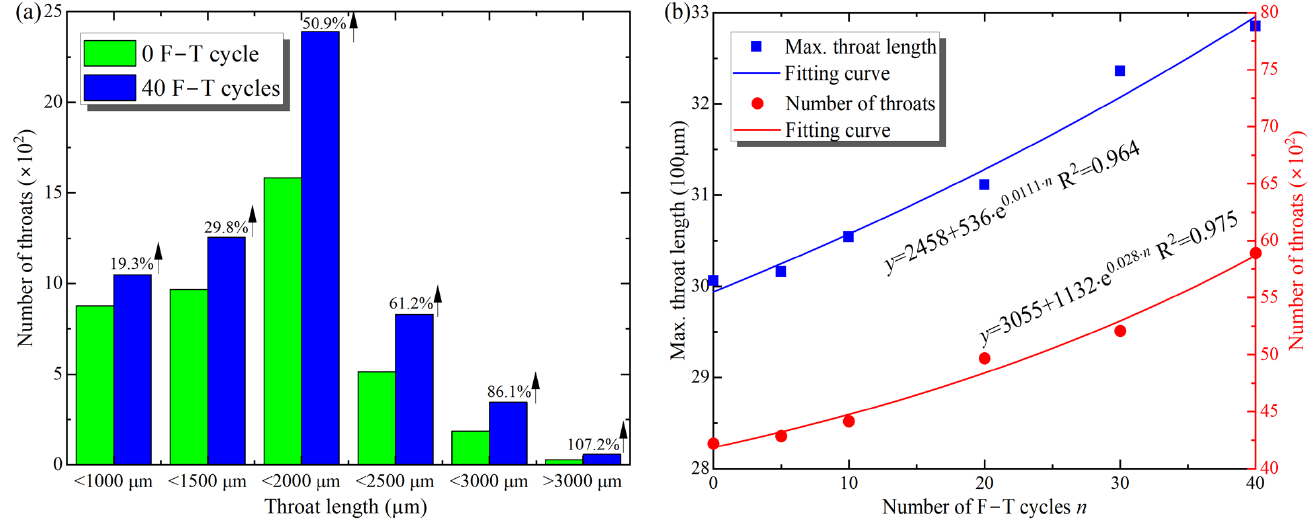
Figure 10. Distribution of the lengths ( a ) and the maximum lengths and total number ( b ) of throats with F–T cycles.